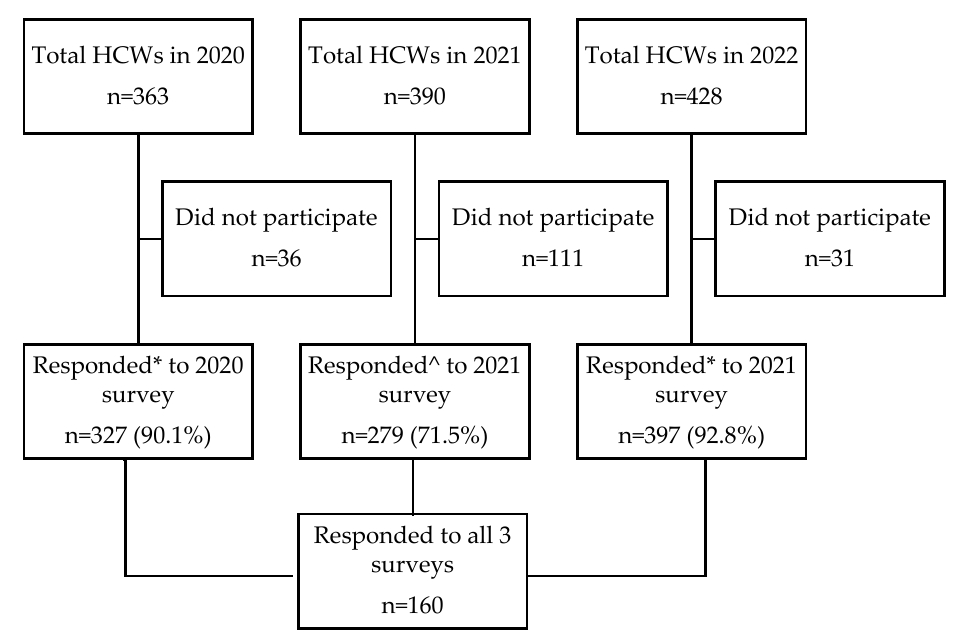
Figure 1. Flow diagram of the COVID-19 studies carried out in June 2020 (1st survey), June 2021 (2nd survey) and June 2022 (3rd survey). * All ED HCWs at the time of the study’s recruitment period were approached for recruitment. ˆ Only ED HCWs who had participated in the first survey in 2020 were approached. Table 1. Characteristics of all ED HCWs in the 2020 (n = 327), 2021 (n = 279) and 2022 (n = 397) cohorts.